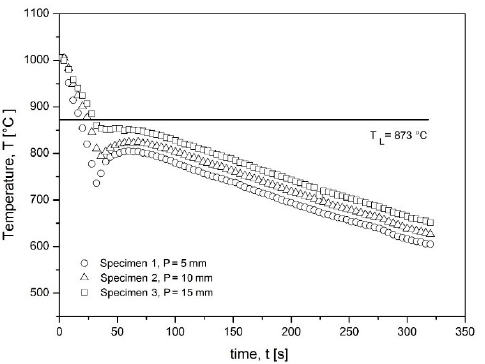
Figure 5. Solidification growth ( S